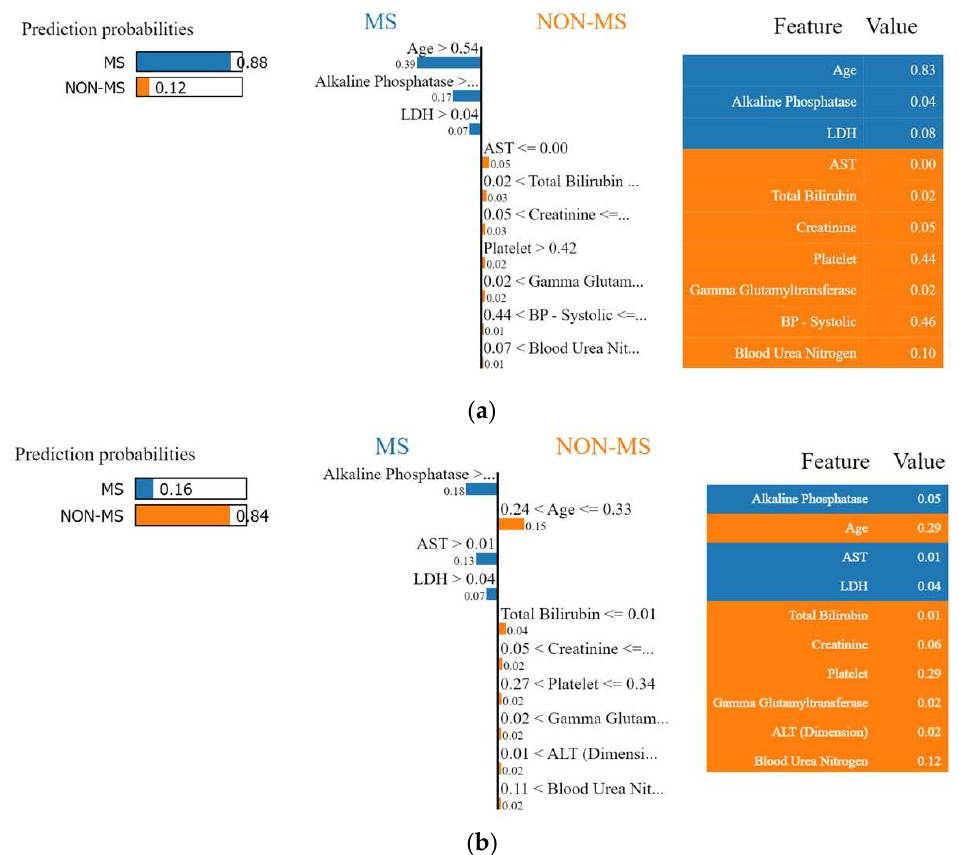
Figure 6. Lime results for the ET model. ( a ) Positive prediction probability, ( b ) negative prediction probability.